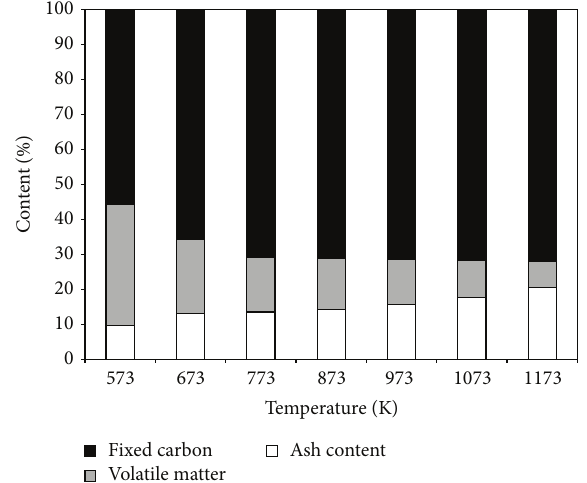
Figure 7: Percentage of volatile, ash, and fixed carbon present in char obtained at different pyrolysis